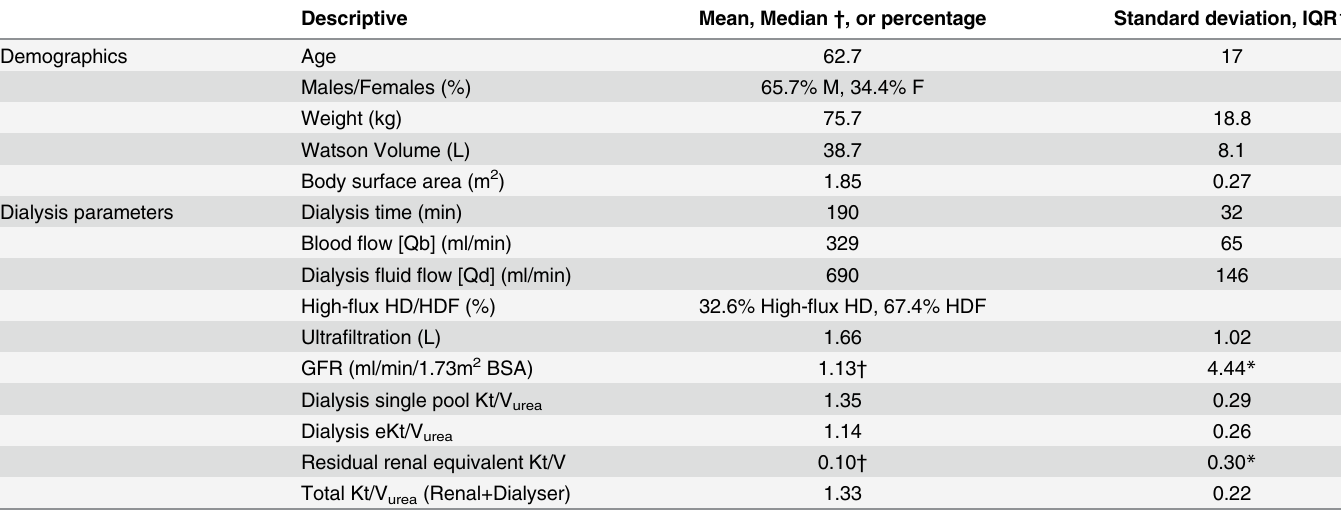
Table 1. Baseline characteristics and dialysis parameters of the study